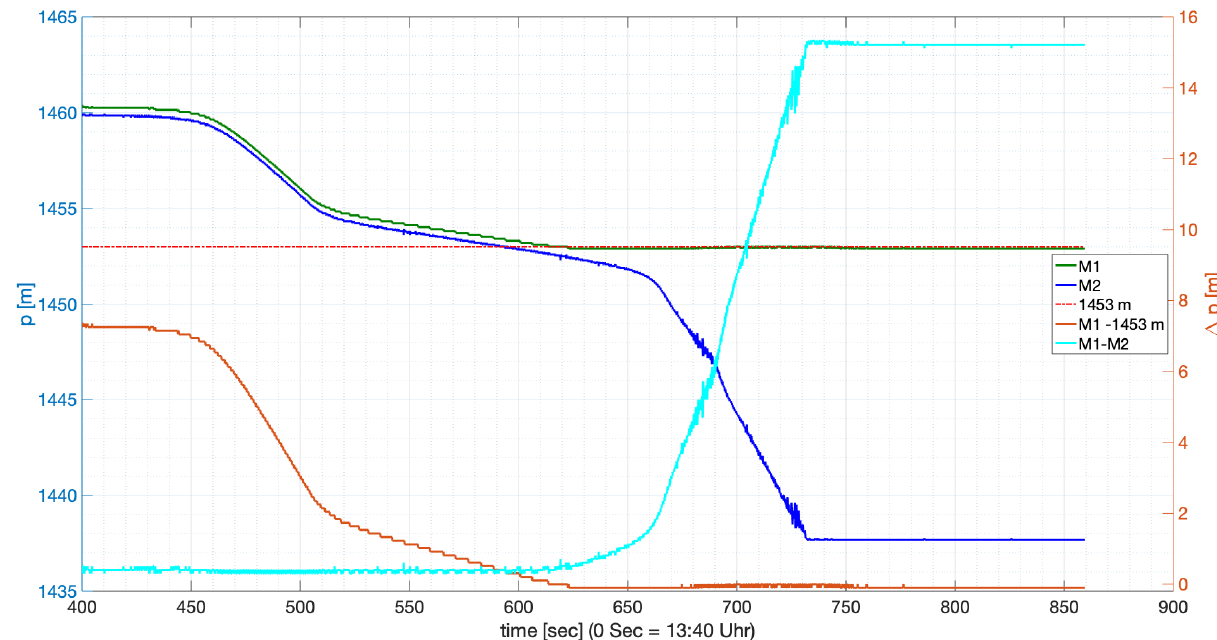
Figure 7. Time series of the measured values for the measurement points M 1 and M 2 for the simulated break of the penstock—the second y -axis at the right shows the differences of M 1 to the top height of the wall (1453 m) as well as the second measurement M